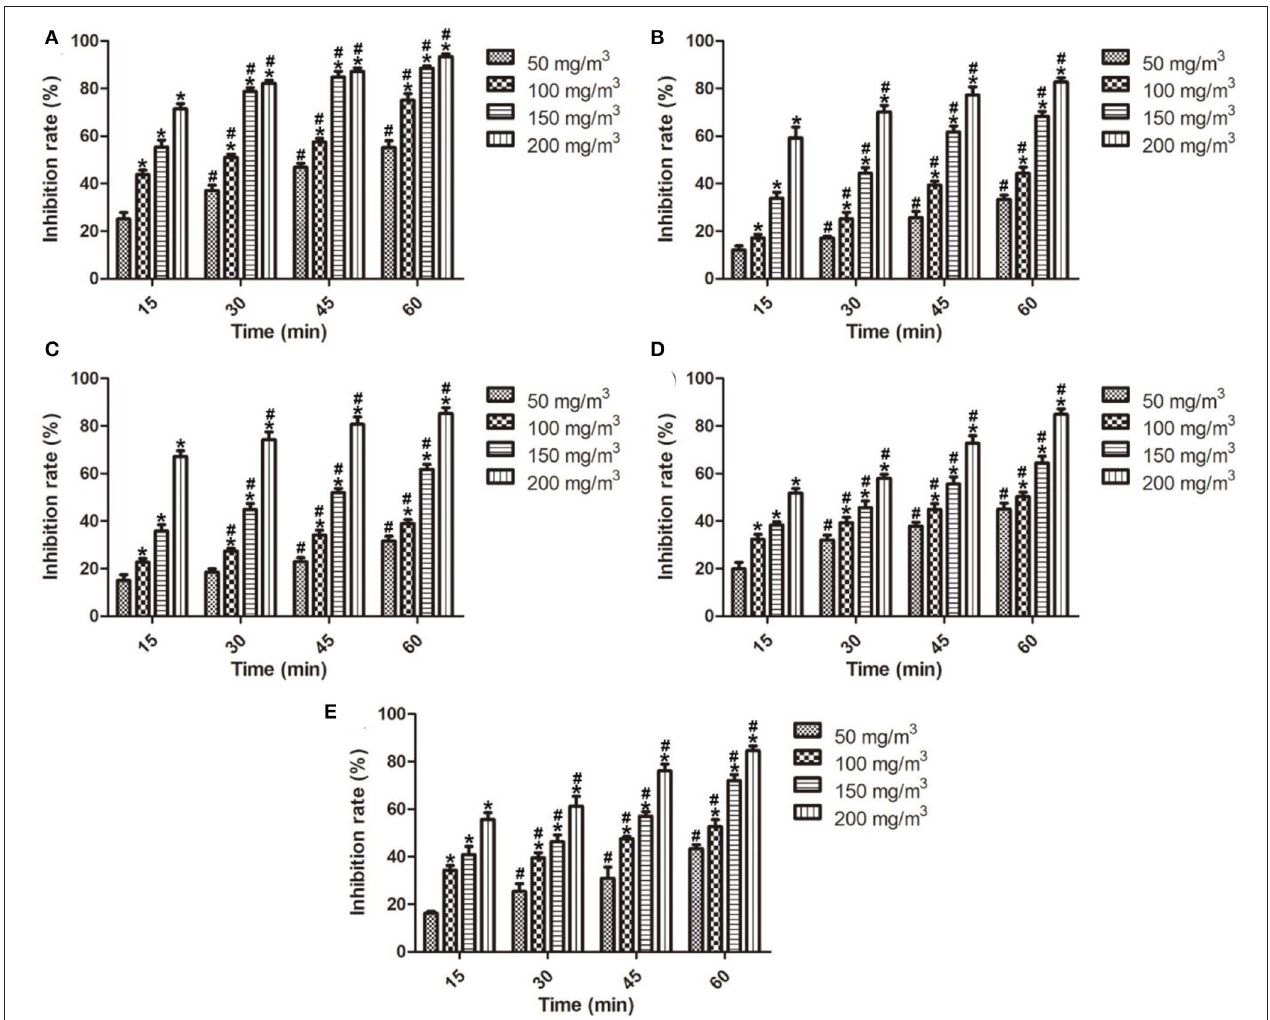
FIGURE 2 | In vitro antifungal effects of ozone fumigation treatment on Penicillium sp. at different ozone concentrations and treatment time. (A) in vitro antifungal effect on the number of colonies, (B) in vitro antifungal effect on the colony diameter, (C) in vitro antifungal effect on the mycelial growth, (D) in vitro antifungal effect on the spore germination, and (E) in vitro antifungal effect on the spore germination. “*” indicated the inhibition rates of ozone fumigation treatment with a significant difference at p < 0.05 compared with the inhibition rates at 50 mg/m 3 . “#” indicated the inhibition rates of ozone fumigation treatment with a significant difference at p < 0.05 compared with the inhibition rates at